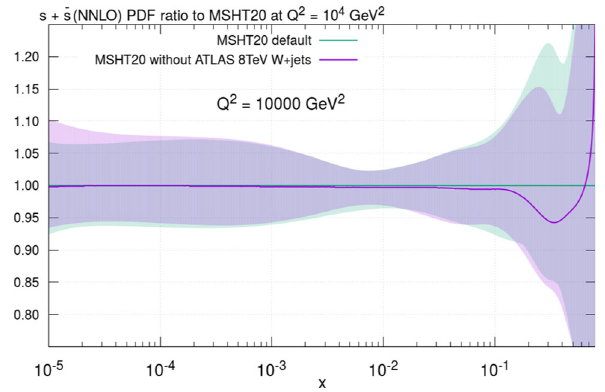
Fig. 69 s + ¯ s PDF ratio to MSHT20 at Q 2 = 10 4 GeV 2 at NNLO